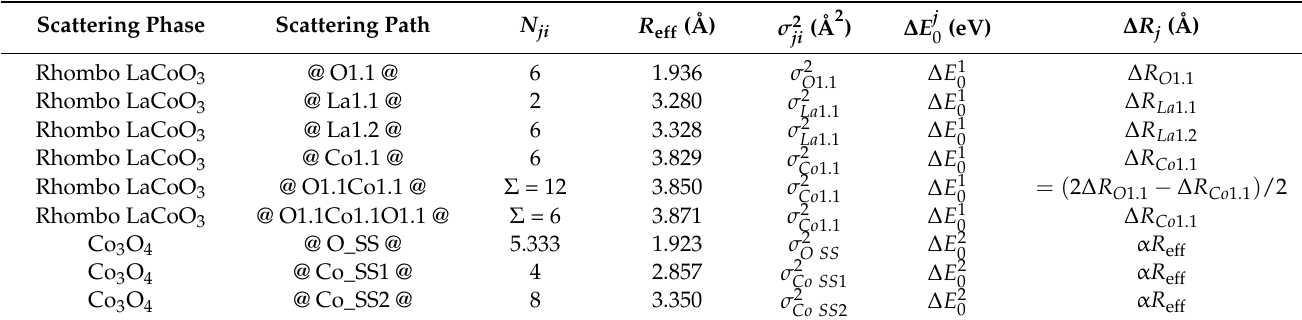
Table 2. EXAFS model for Co K -edge spectrum of the x = 0 sample based on the two-phase mixture. Co 3 O 4 has two inequivalent absorbing sites. The symbol @ denotes the absorbing atom.